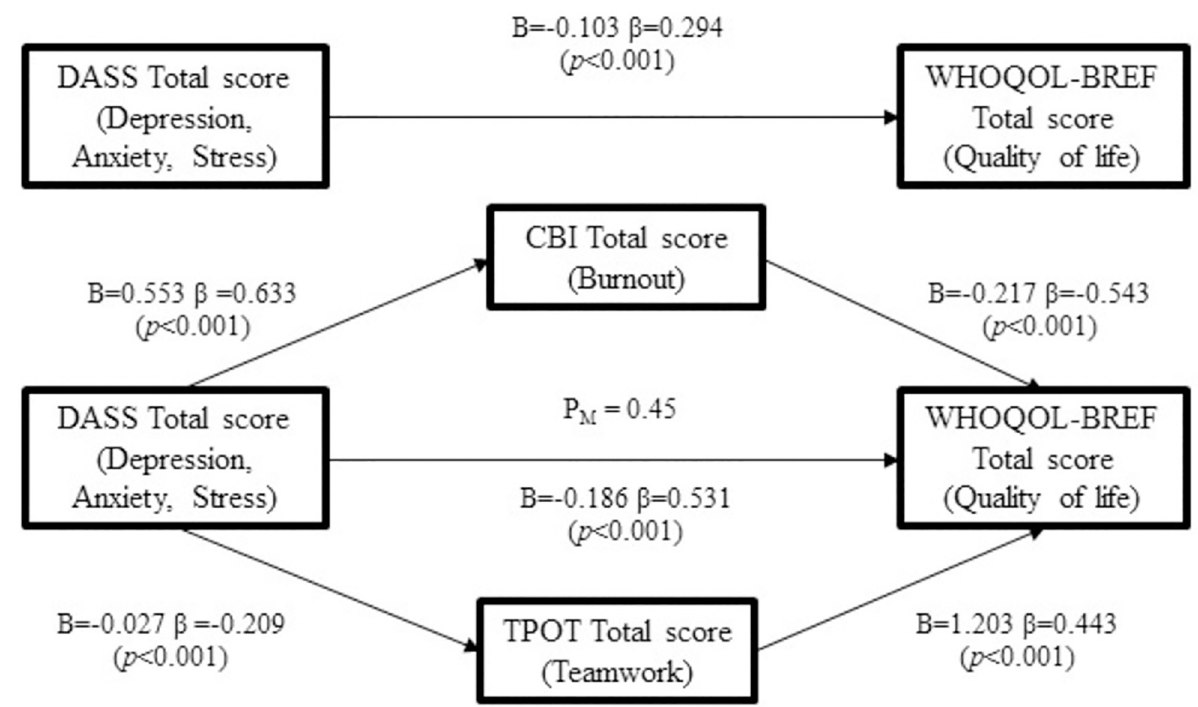
Fig 3. Mediation model of the effects of burnout and teamwork on the relationship between DASS and quality of life. (N = 351) (DASS = Depression, Anxiety, Stress Scale; CBI = Copenhagen Burnout Inventory; TPOT = Teamwork Performance Observation Tool; P M = the ratio of the indirect effect to the total